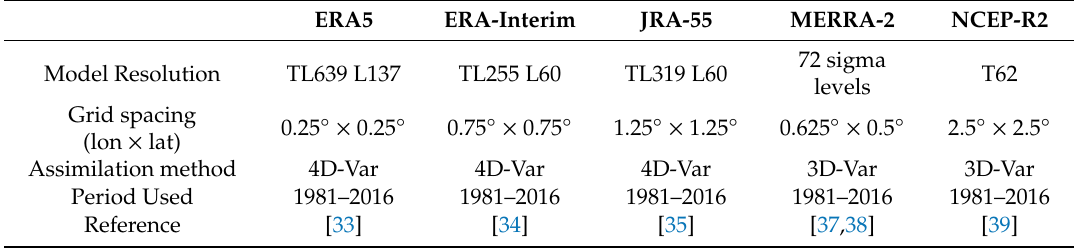
Table 1. Details of the five global reanalyses used in the present